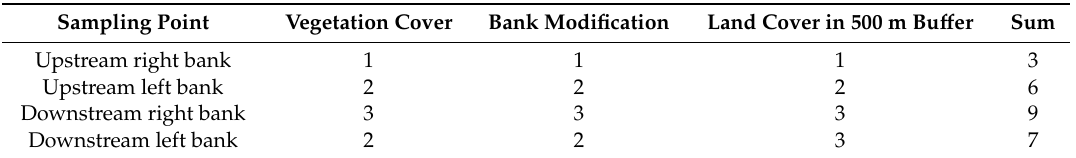
Table 1. Classification of sampling points according to land use, following Belletti et al. [29]. Rankings: 1—undisturbed / natural, 2—disturbed-modified, 3—artificial-heavily modified. Sampling Point Vegetation Cover Bank Modification Land Cover in 500 m Bu ff er Sum Upstream right bank 1 1 1 3 Upstream left bank 2 2 2 6 Downstream right bank 3 3 3 9 Downstream left bank 2 2 3